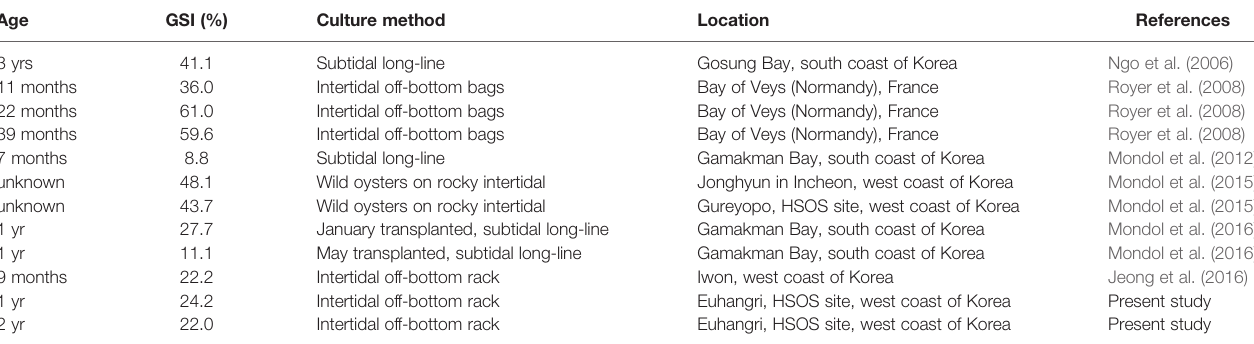
TABLE 2 | Summary of the gonad somatic index (GSI) and fecundity of female Crassostrea gigas previously reported from elsewhere and the present